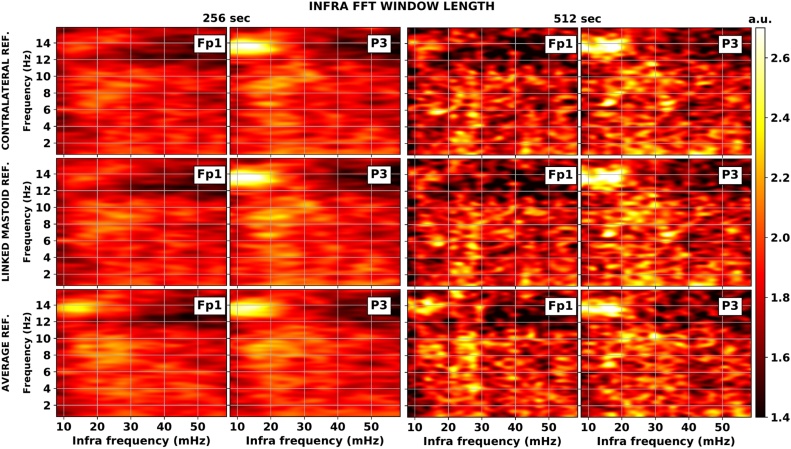
Effect of re-referencing and FFT window size on ISO (relative infra power spectral density of the absolute power spectral density of sleep EEG signals). Average of 34 participants’ baseline NREM stage 2 sleep (contralateral, linked mastoid and average reference). Relative ISO spectrum is calculated from the 2 s temporal resolution of the absolute power spectrum's evolution (0.25 Hz frequency resolution). Minimum length contiguous FFT window for the ISO spectrum is 256 s (to the left) and 512 s (to the right).